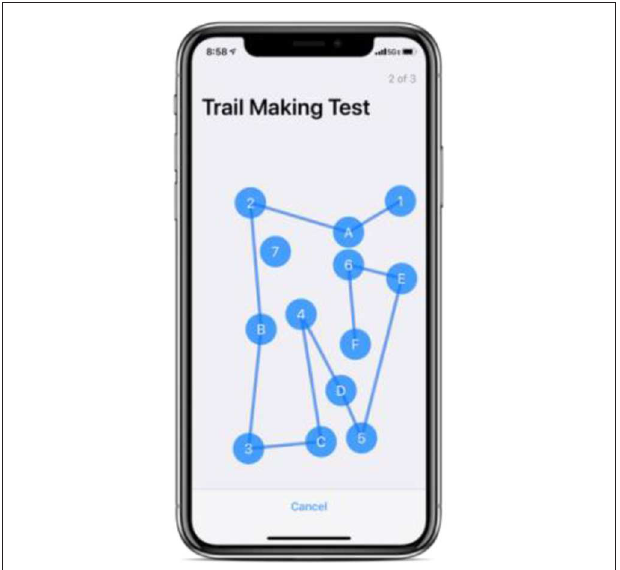
FIGURE 3 | Sample of Trail Making